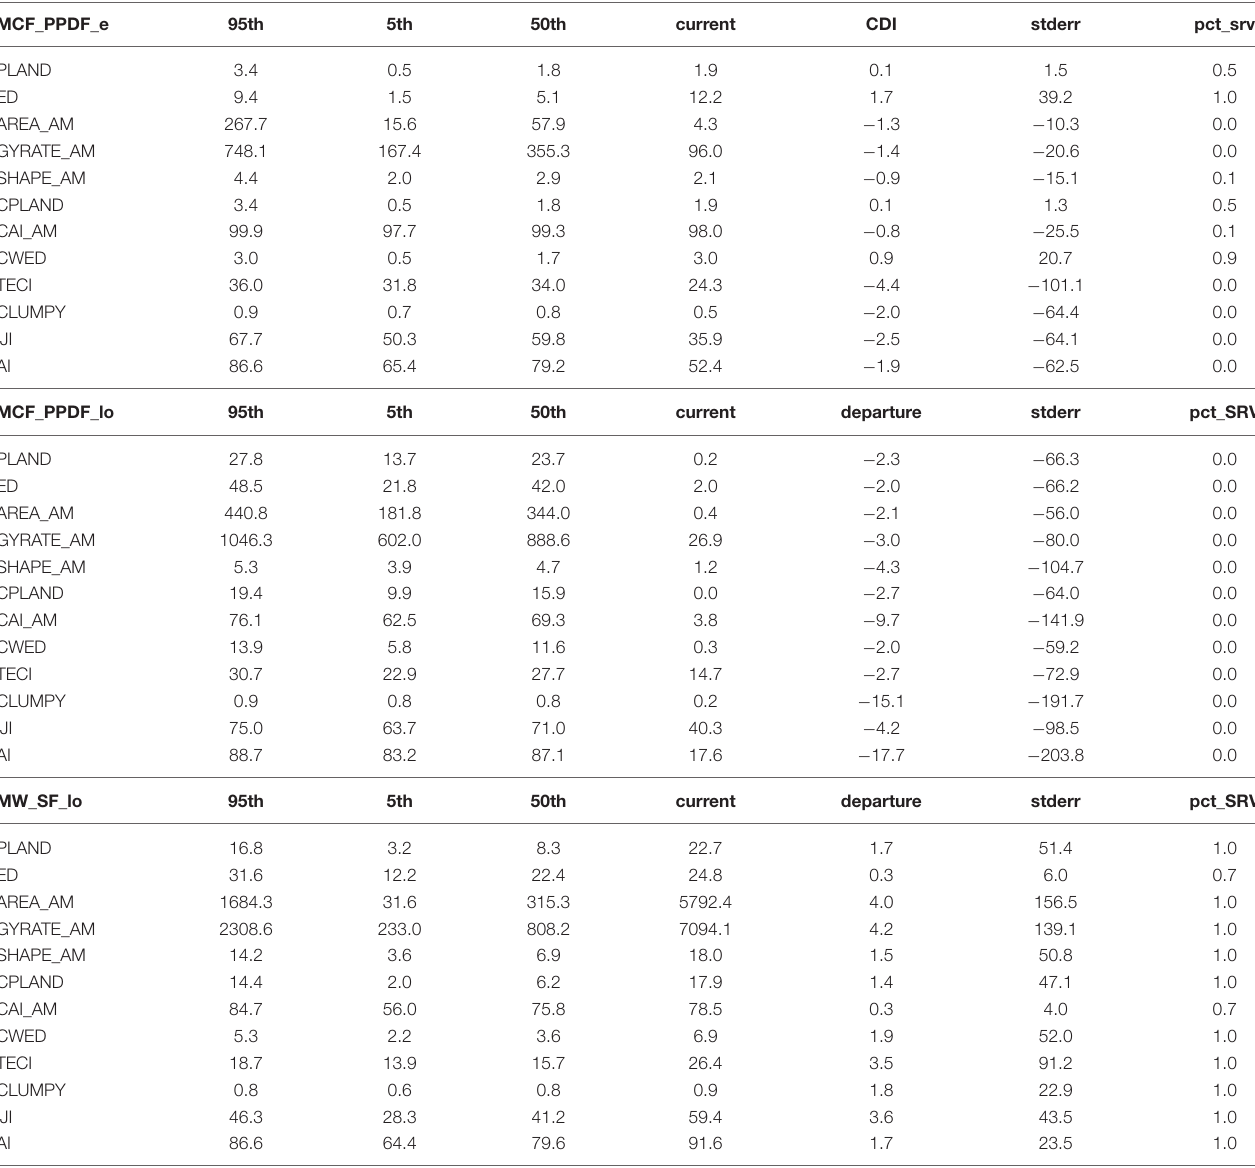
TABLE 2 | Simlulated range of variability of 12 class-level landscape